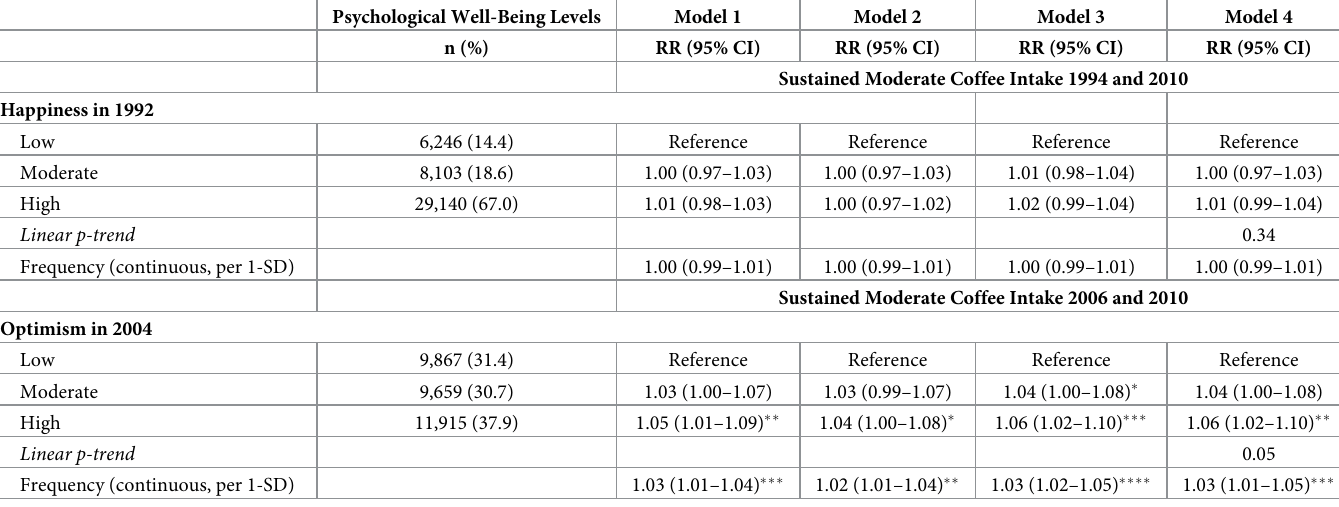
Table 3. Generalized estimating equations with a Poisson distribution evaluating the association of baseline levels of happiness (N = 43,489) and optimism (N = 31,441) respectively with likelihood of reporting sustained moderate caffeinated coffee intake a,b